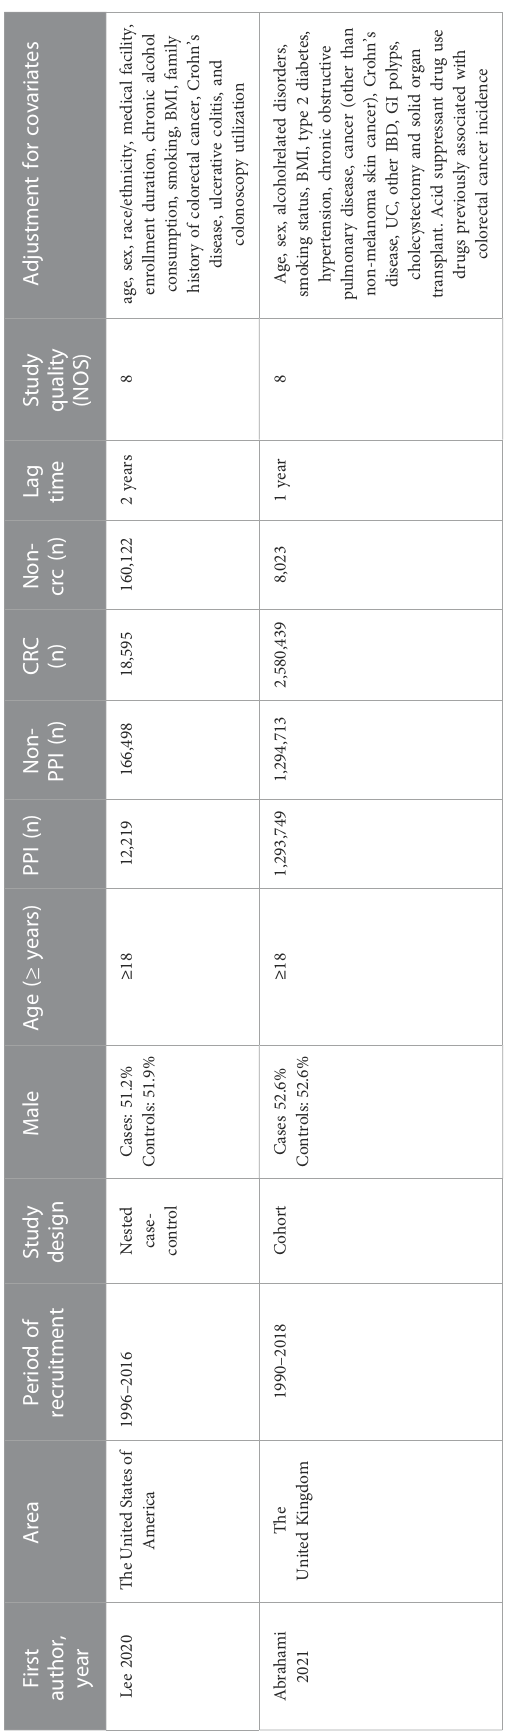
(RR = 2.04, 95% CI: 1.58 – 2.63, I 2 < 50%), population (RR = 1.58, 95% CI: 1.36 – 1.83, I 2 < 50%) and mean age (RR = 1.56, 95% CI: 1.34 – 1.81, I 2 < 50%)and all were related to the risk of